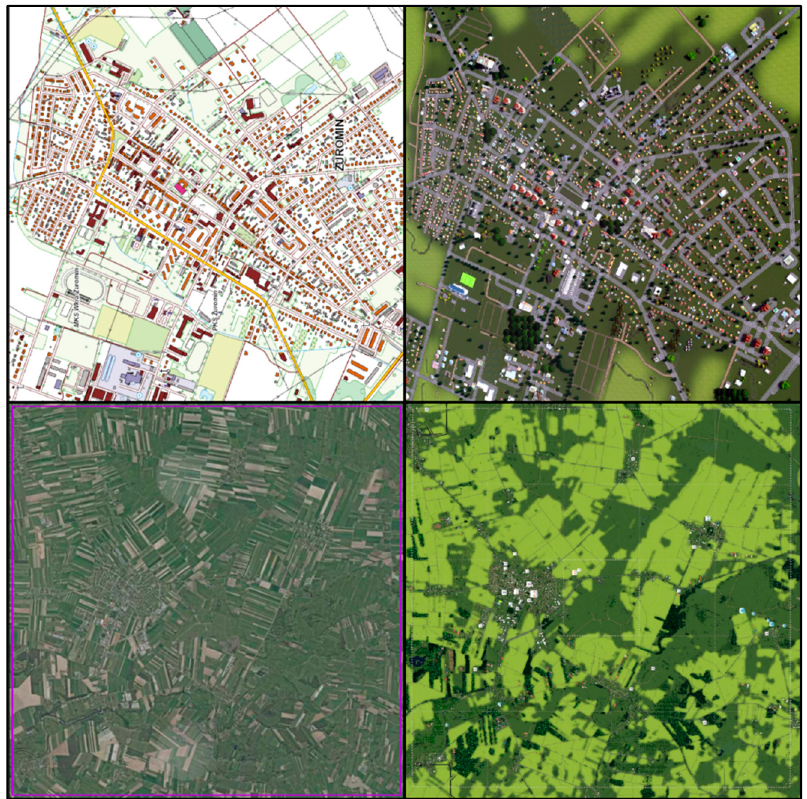
Figure 6. Comparison between topographic data visualised using a GIS toolset (left side: topographic data base—top, ortophotomap—down) and imported into the game engine of Cities: Skylines ( right side: buildings and roads—top, landcover—down ) .